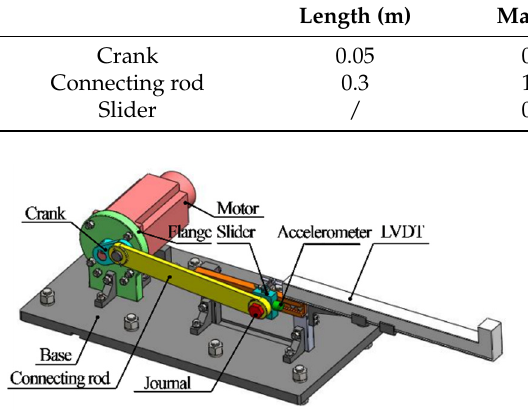
Figure 4. The test rig of the mechanism [29].